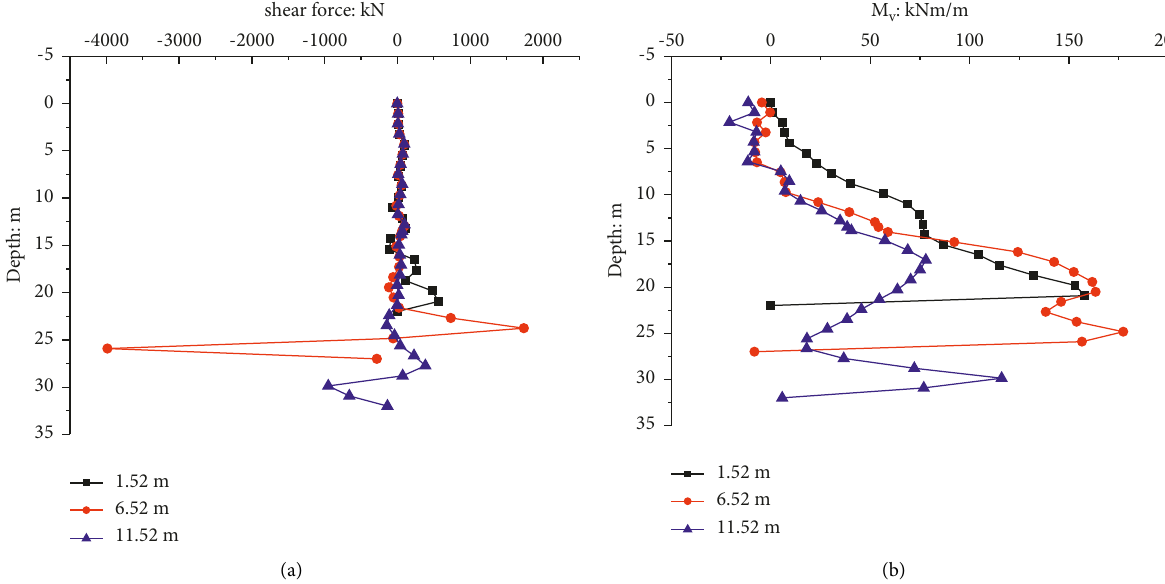
Figure 22: The influence of soil penetration depth on the distribution of wall internal forces (excavation 5). (a) Shear force. (b) Bending moment.